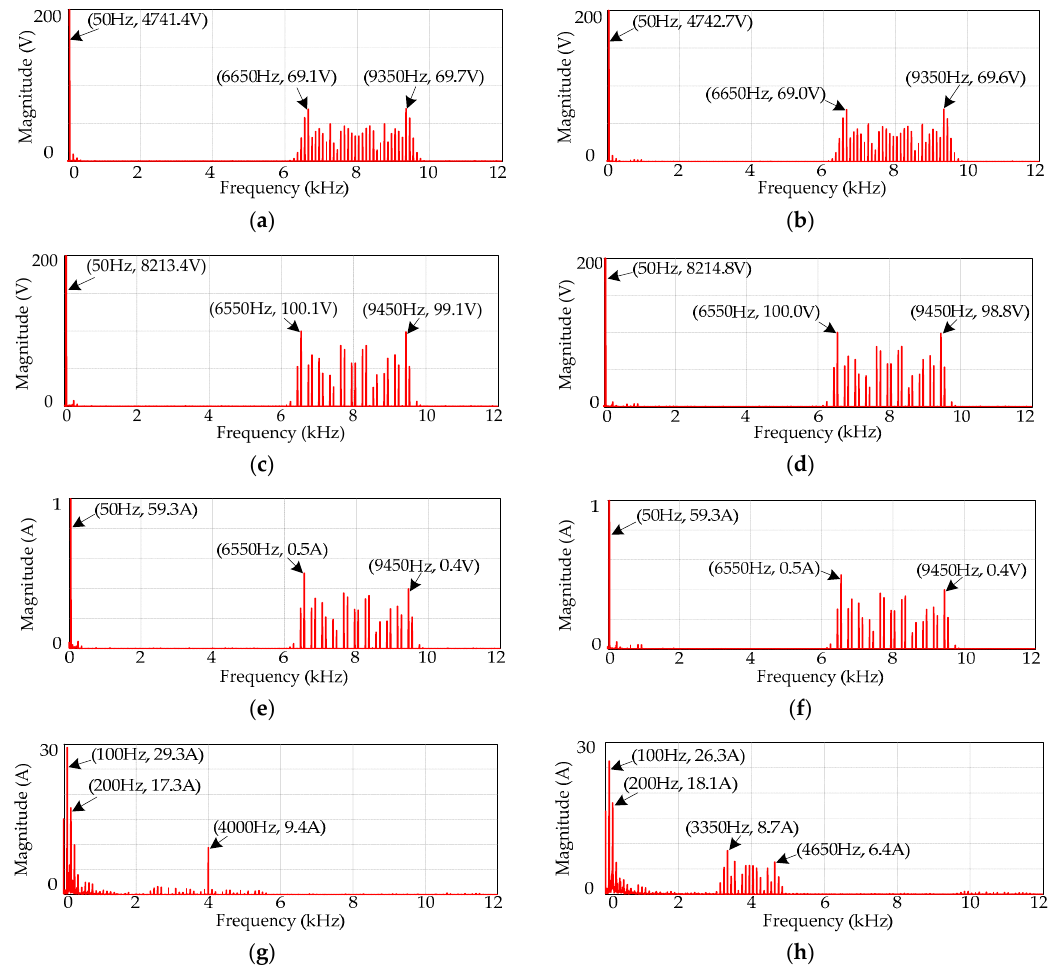
Figure 9. Comparison of harmonic spectra between DCPDPWM and PSCPWM methods with output voltage harmonics minimization scheme: ( a ) phase voltage of DCPDPWM; ( b ) phase voltage of PSCPWM; ( c ) line-to-line voltage of DCPDPWM; ( d ) line-to-line voltage of PSCPWM; ( e ) phase current of DCPDPWM; ( f ) phase current of PSCPWM; ( g ) circulating current of PDPWM; ( h ) circulating current of PSCPWM.